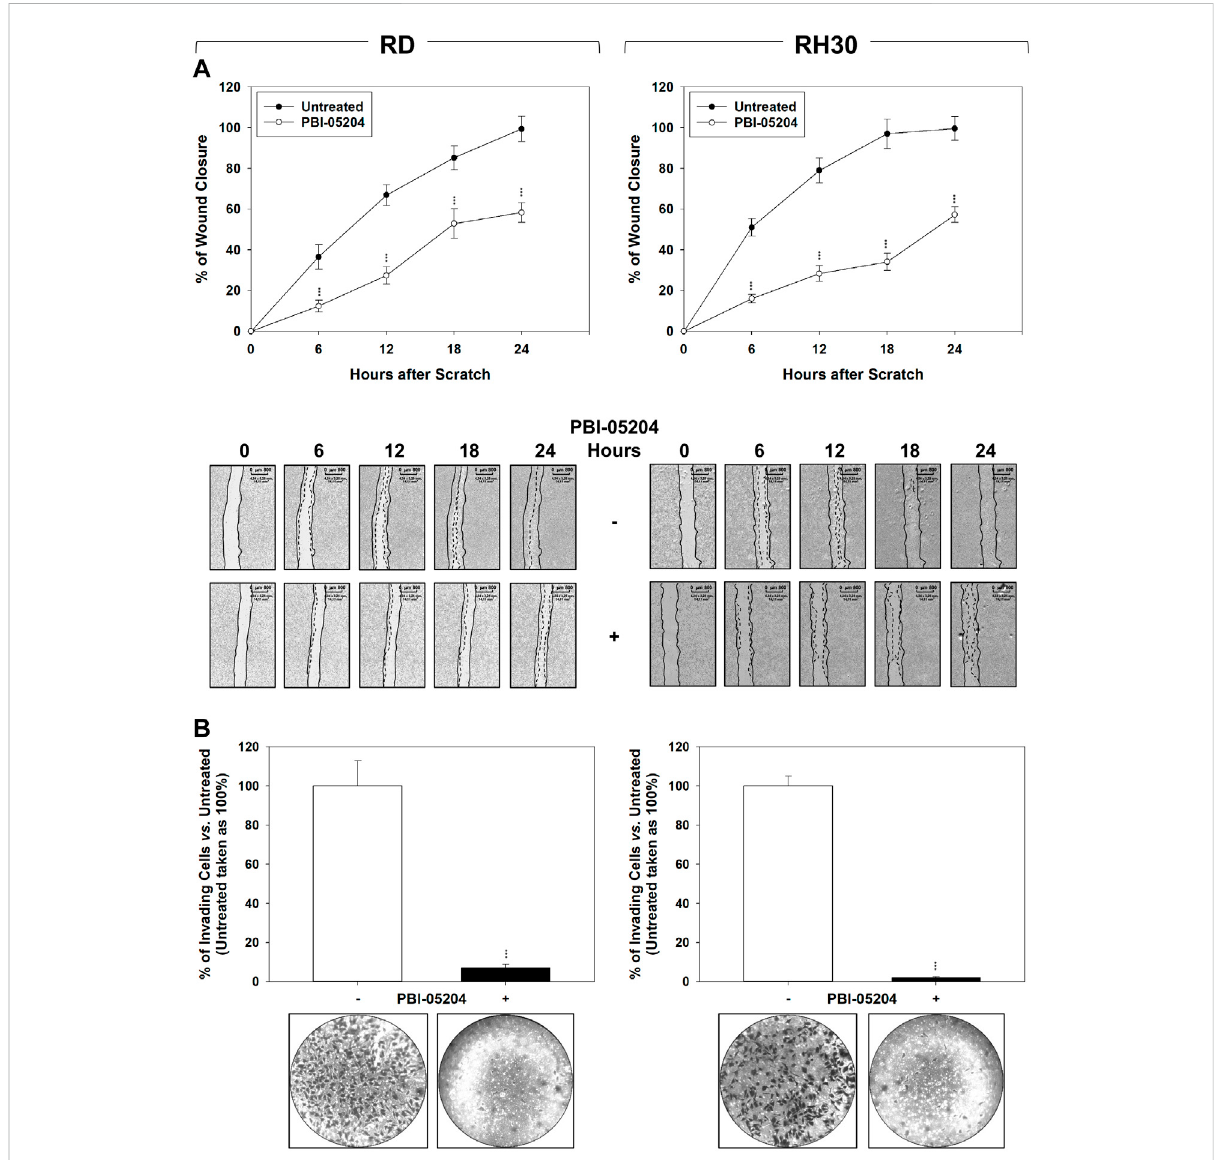
FIGURE 4 PBI-05204impairsmigrationandinvasionasdeterminedbywoundclosurebyFN-RMSandFP-RMScells. (A) WoundhealingexperimentsinRD (Left)andRH30(Right)celllines, treatedornotwith PBI-05204IC 50 .Thescratch andthenPBI-05204 treatment wasmadeattime 0andmaintained ornotfor24 h.Thedotted linesrepresenttheedgesofthewound. Photographs(LeftPanel)weretakenunderlightmicroscope(×10 magni fi cation). The migration index was plotted in bar graphs as the % of wound area (Right Panel). Lines (Up) represent the mean values of three independent experiments ±SD. Statistical signi fi cance: ** p ≤ 0.01, *** p ≤ 0.001 vs. Untreated cells. Representative data from three independent experiments is shown (Down). (B) Matrigel invasion assay using a Transwell system. Results represent the mean values of three independent experiments ±SD (Up). Statistical signi fi cance: * p ≤ 0.05, ** p ≤ 0.01, *** p ≤ 0.001 vs. Untreated. Representative data from three independent experiments is shown